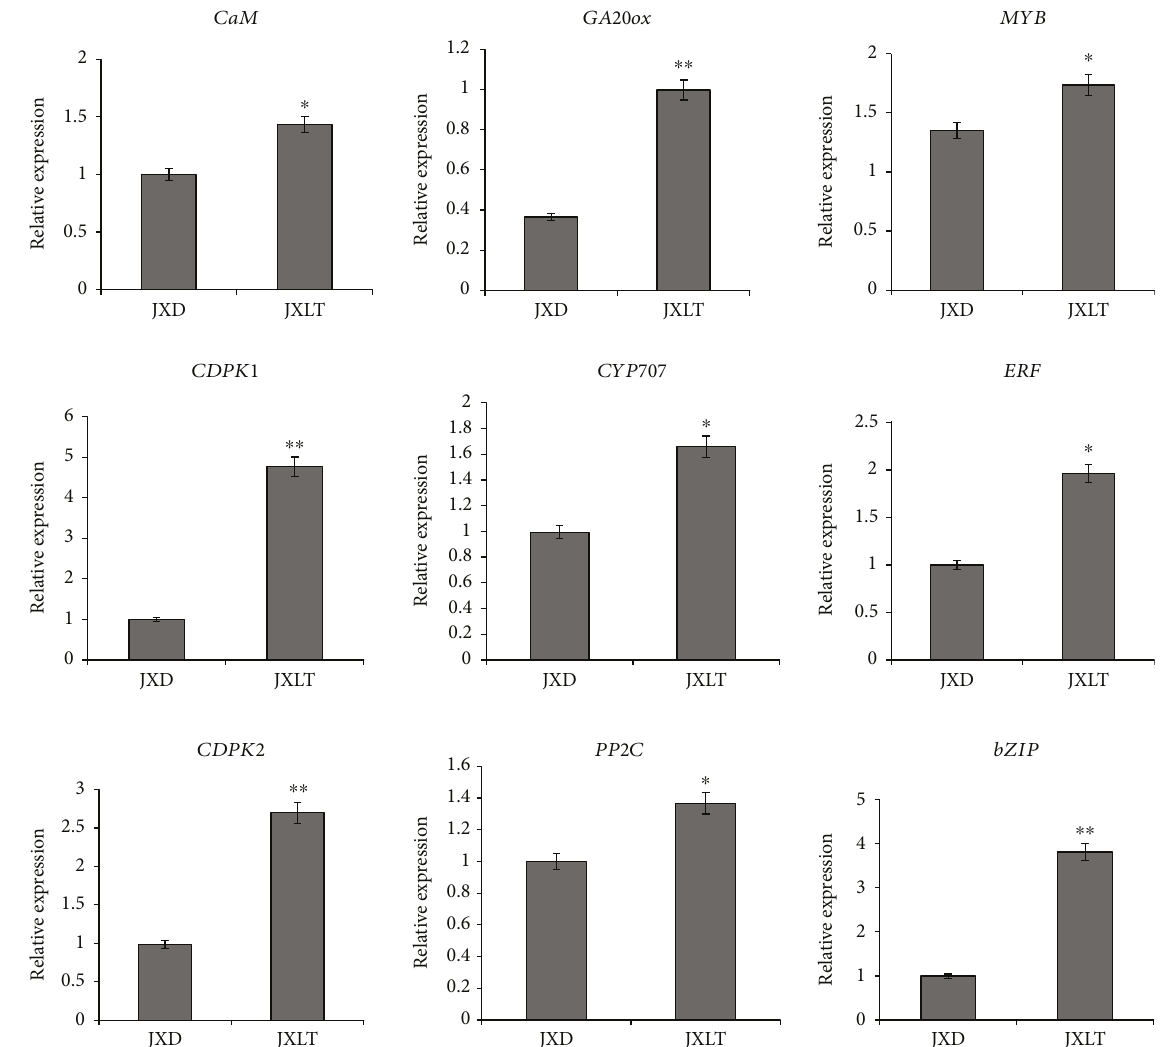
Figure 9: qRT-PCR analysis of 9 key di ff erentially expressed genes. Statistical signi fi cance: ∗ P < 0 05 ; ∗∗ P < 0 01